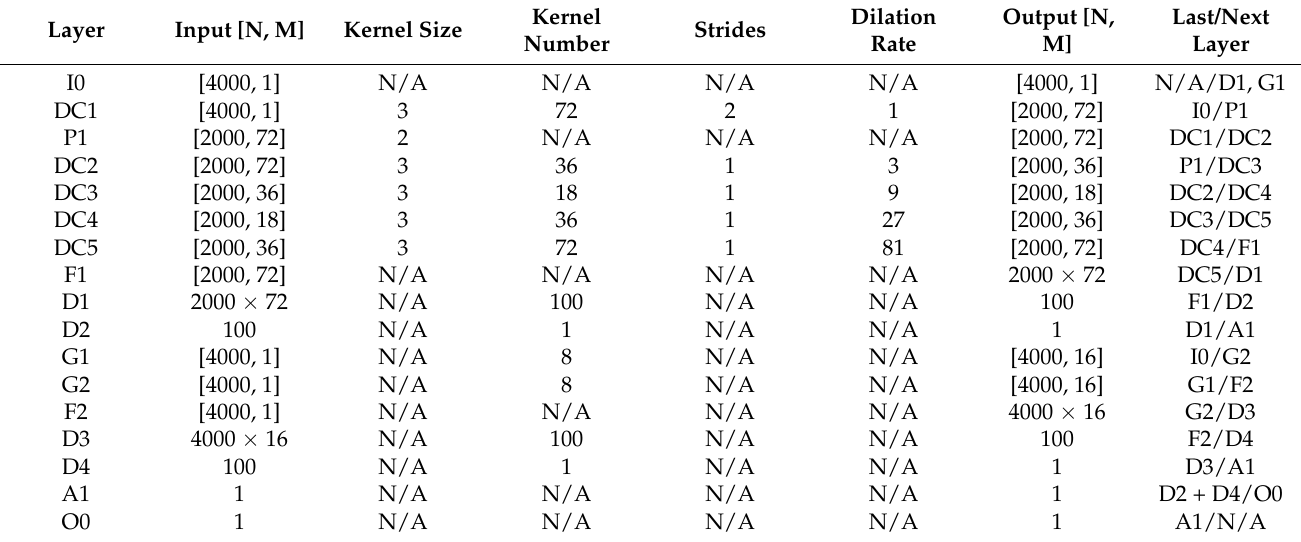
Table 1. Specifications of the DCNN-BiGRU architecture.